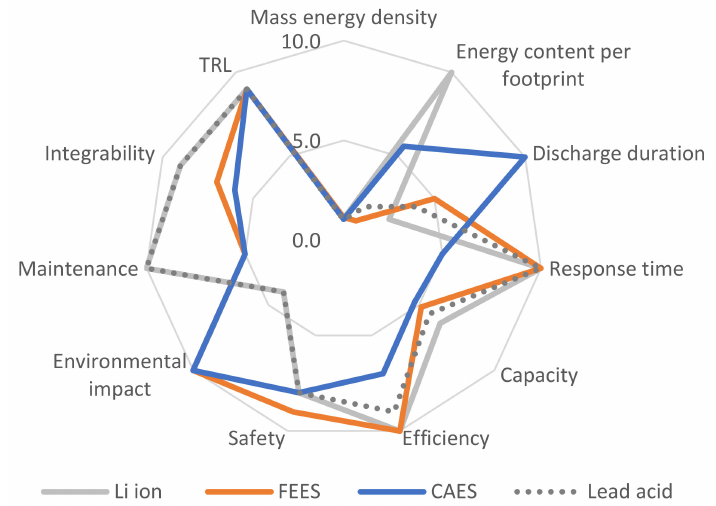
Figure 9. Spider chart of the most promising technologies for Scenario A-2030 and how they perform in each KPI. The data are available in Table 2.